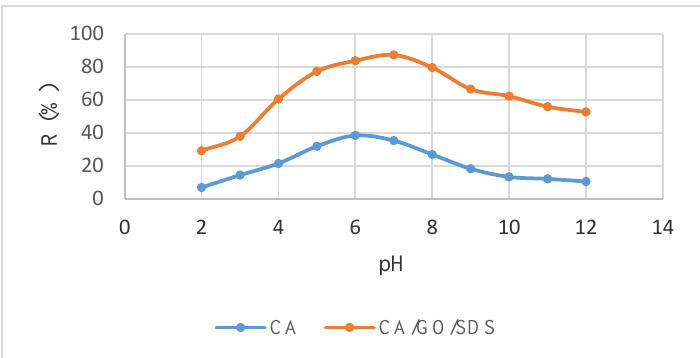
Figure 3. The effect of the initial pH on phosphate adsorption by CA and CA/GO/SDS .